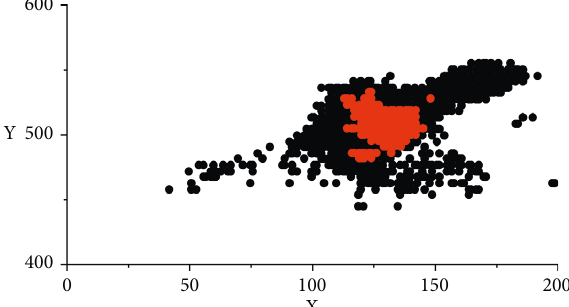
Figure 12: Comparison of wrist coordinates between fatigue and normal state.